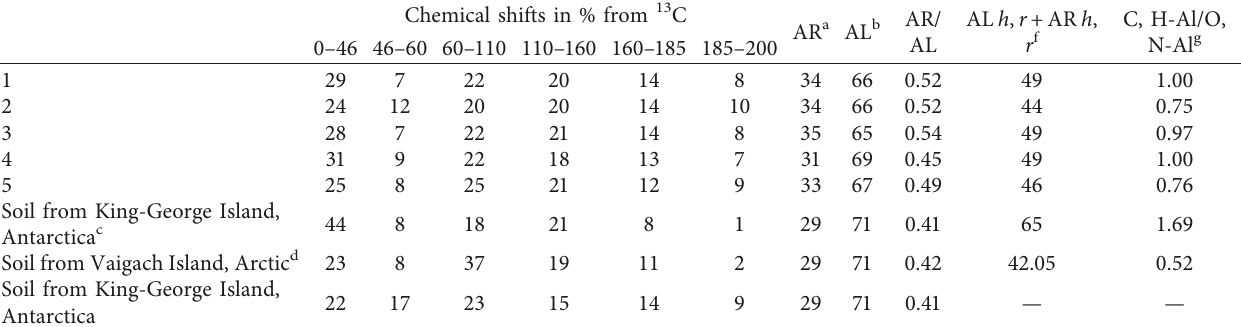
Table 3: Percentage of carbon in the main structural fragments of HAs from the studied surface soil horizons (according to CP/MAS 13 C NMR data).